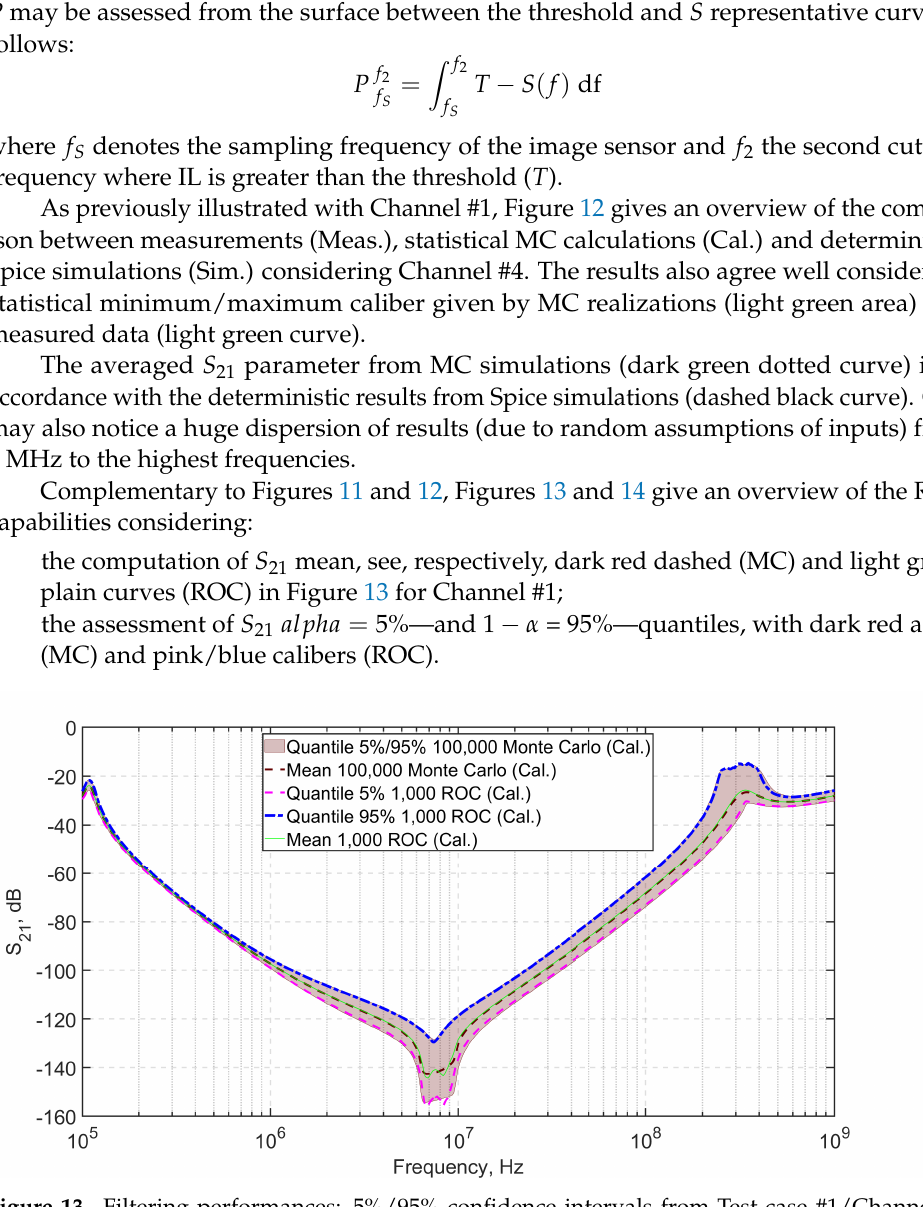
Figure 13. Filtering performances: 5%/95% confidence intervals from Test case #1/Channel #1 including MC samples and ROC